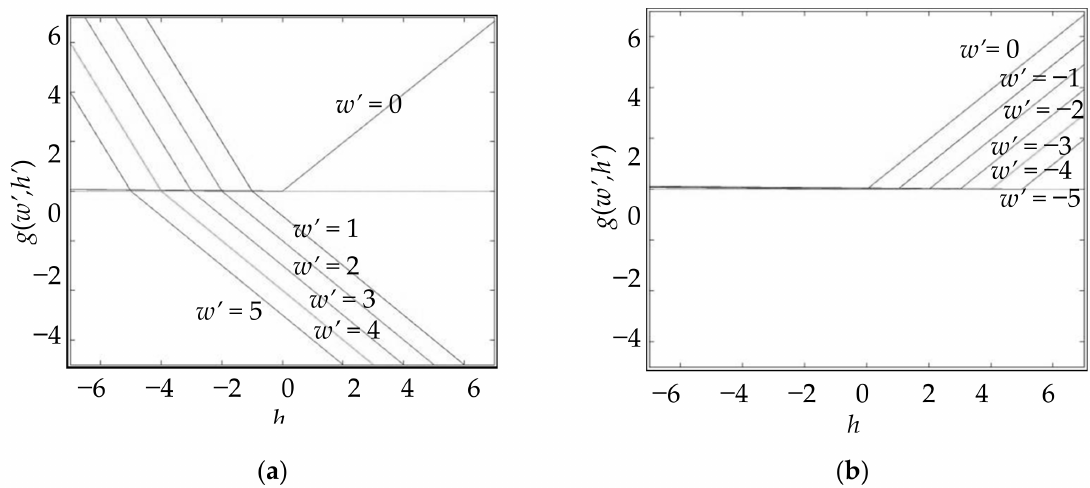
Figure 4. The curve g ( w (cid:48) , h (cid:48) ) at σ = PReLU. ( a ) w’ > 0 ; ( b ) w (cid:48) < 0. When the conditions ( σ = PReLU , h’ < 0 , w’ < 0, and y label > 0) are met, the algorithm has the possibility of